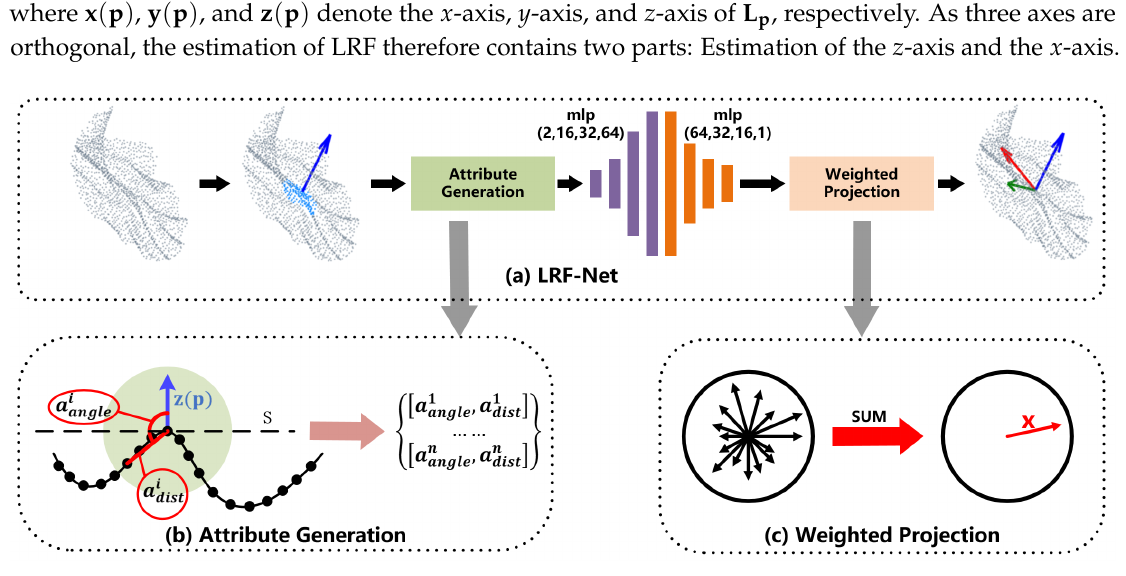
Figure 2. The architecture of LRF-Net. The input to LRF-Net is a local surface and we calculate its normal as the z -axis of the LRF. Then, the local surface is converted to a set of rotation variant attributes. Next, a projection weight for every point is computed with mlp. At last, the x -axis is calculated by the weighted vector-sum of all the projection vectors and the y -axis is calculated by the cross product between the z -axis and x -axis. The LRF is formed as the combination of the x -axis, y -axis and z